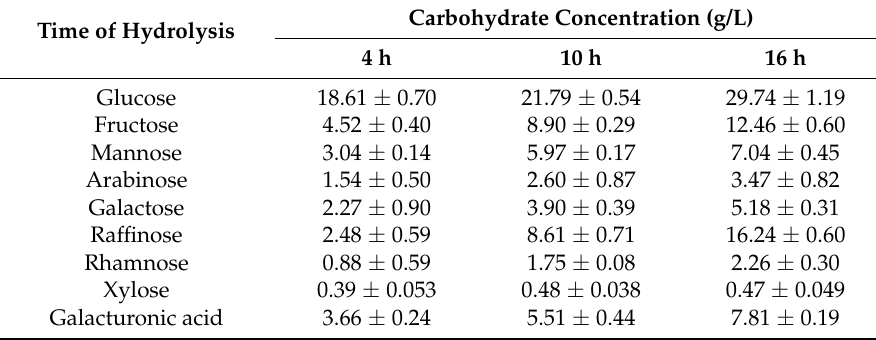
Table 1. Composition of the sugar beet pulp medium during hydrolysis (0.1 mL of Viscozyme and 0.1 mL Ultraflo Max (Novozymes)/50